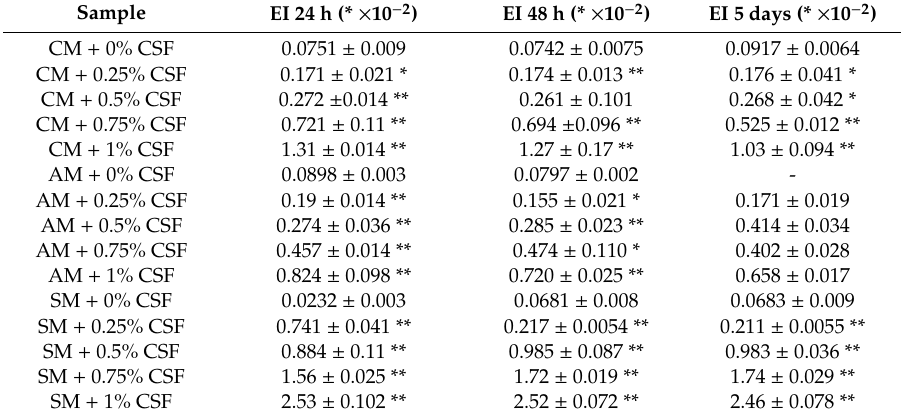
Table 4. EI (nm − 2 ) values obtained at the end of fermentation and after 24h, 48h and 5 days of storage at 4 ◦ C. The results are the mean of three experiments ± standard deviation. (* p < 0.05; ** p < 0.001 of milk-based yogurt-like structure with respect to the same storage time of samples without